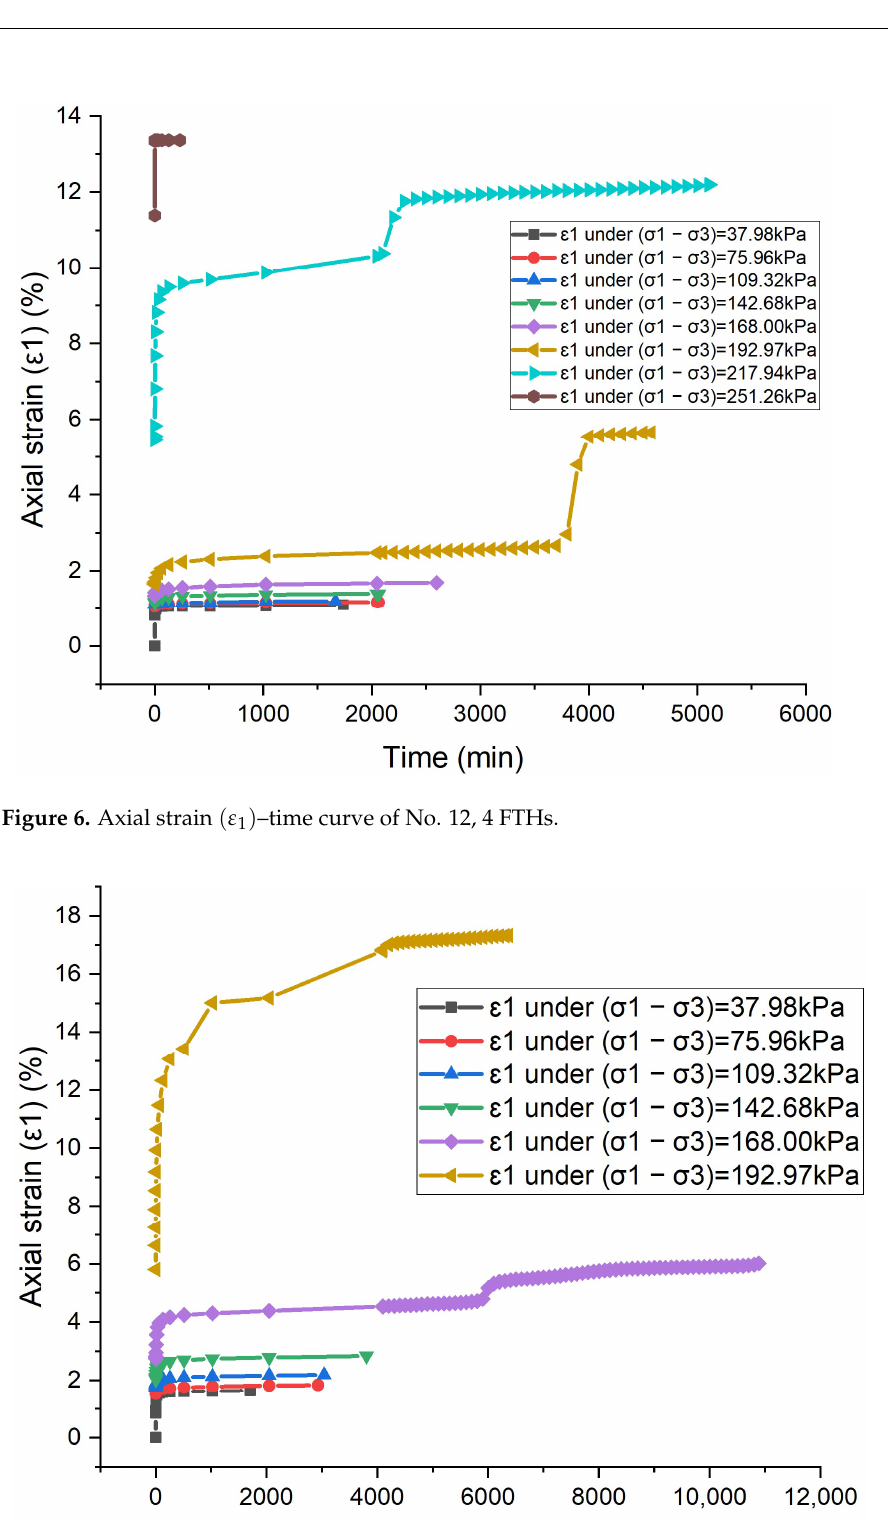
Figure 5. Axial strain (𝜀